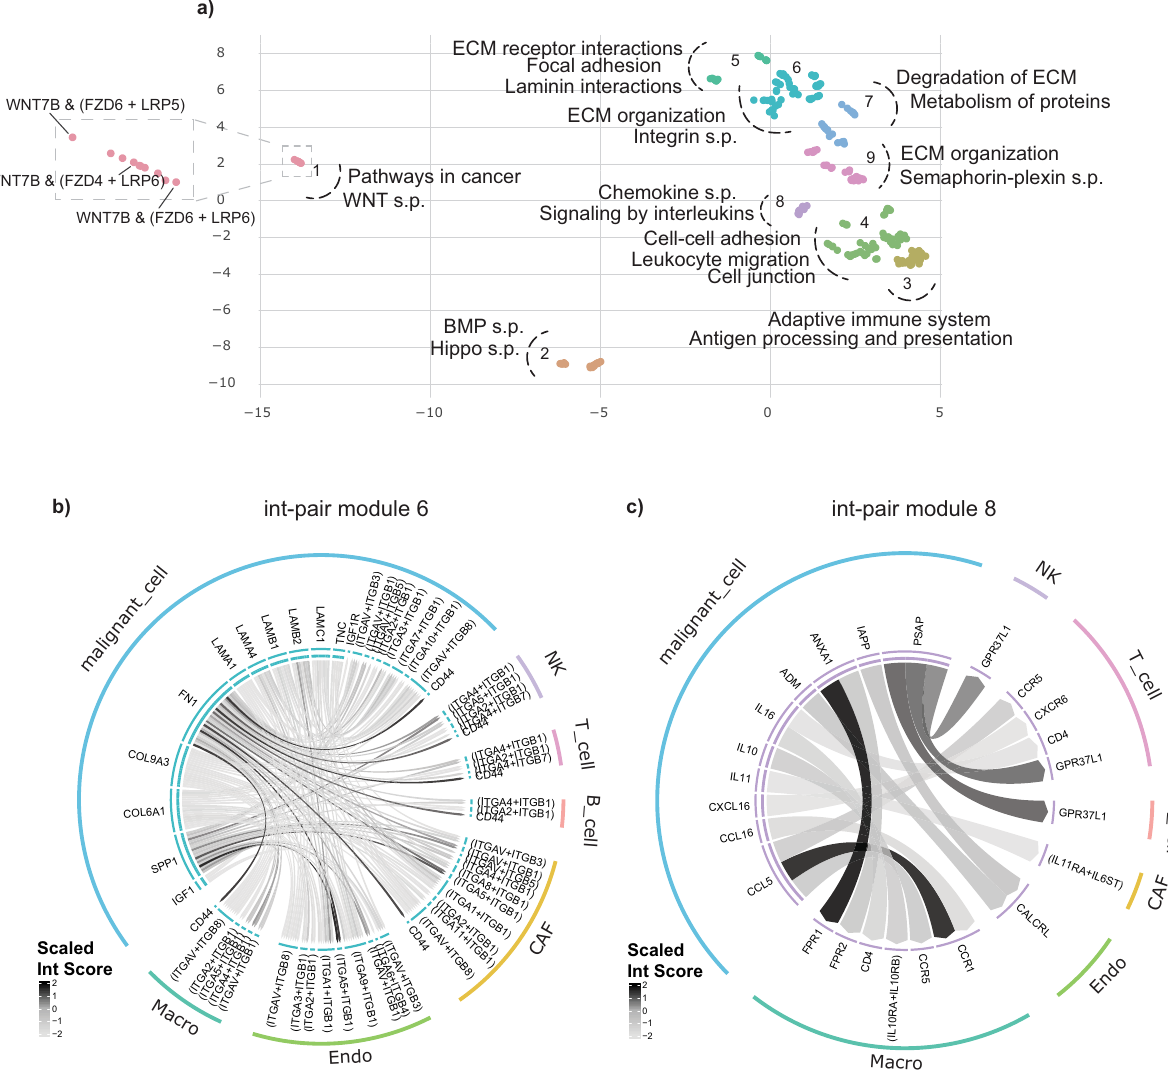
Fig. 3 InterCellar drives the de fi nition of interaction-pair modules uncovering distinct functional pro fi les of communication. a UMAP of int-pairs enriched in melanoma malignant cells, when subsetting to directed-outgoing interactions. Each dot represents one int-pair, as shown, for example, in the inset corresponding to int-pair module #1. For each module, we manually selected functional terms from a list of signi fi cant terms (one-sided permutation test, p < 0.05) computed and displayed by InterCellar in a table. The selected terms serve as an example for identifying the biological functions of each module. b , c Circle plots for int-pair modules #6 and #8, respectively. Cell types are shown in the outer circle, while int-pairs are displayed in the inner one. Directional links originate from ligands and are pointing towards receptors; they are colored by a scaled ( − 2,2) interaction score to highlight relative differences in expression. s.p. - signaling pathway, ECM - extracellular